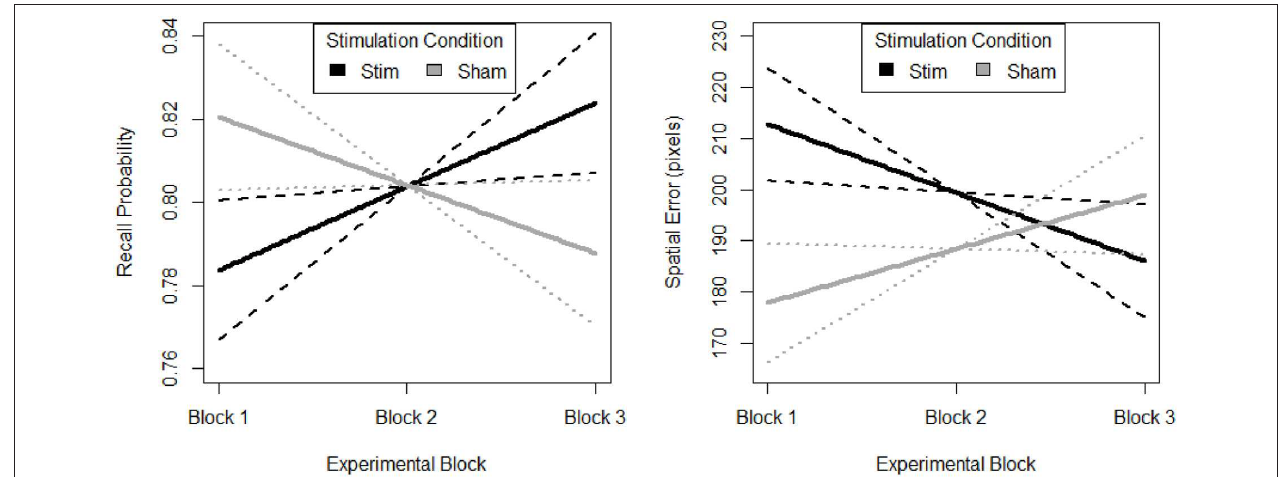
FIGURE 5 | Behavioral performance (Left. probability, Right. error) on spatial memory task. Block 1, both groups receive sham, block 2, stim group received stimulation, sham group received sham, and block 3, both groups were monitored for 33 additional trials of the task. Solid lines depict fixed effects regression slopes, dashed lines represent 95% confidence bands of regression estimate.